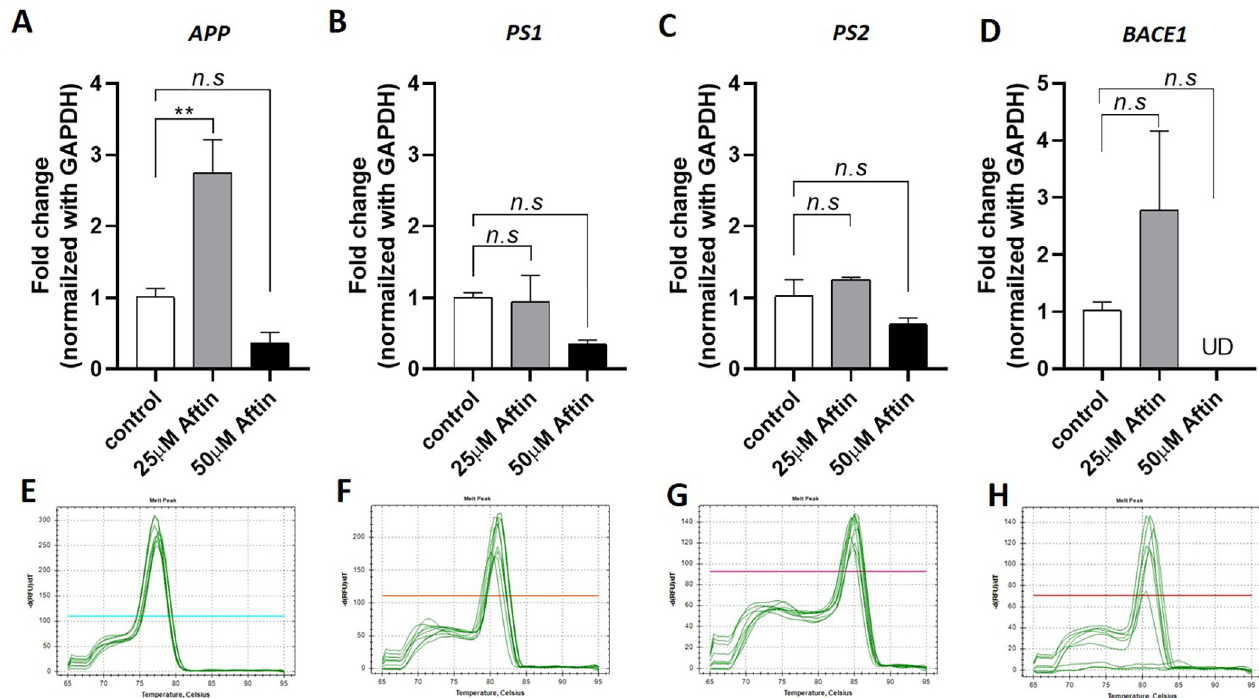
Fig 4. Gene expression analysis A-D) The expression of amyloid-related genes, APP PS1 , PS2 , and BACE1 , respectively upon Aftin-4 treatment for 24 hours. Bar graph represents the mean ± SE (n = 3). �� : p < 0.01. n.s: not statistically different. E-H) Melt curves analysis of APP , PS1 , PS2 , and BACE1 , respectively from all